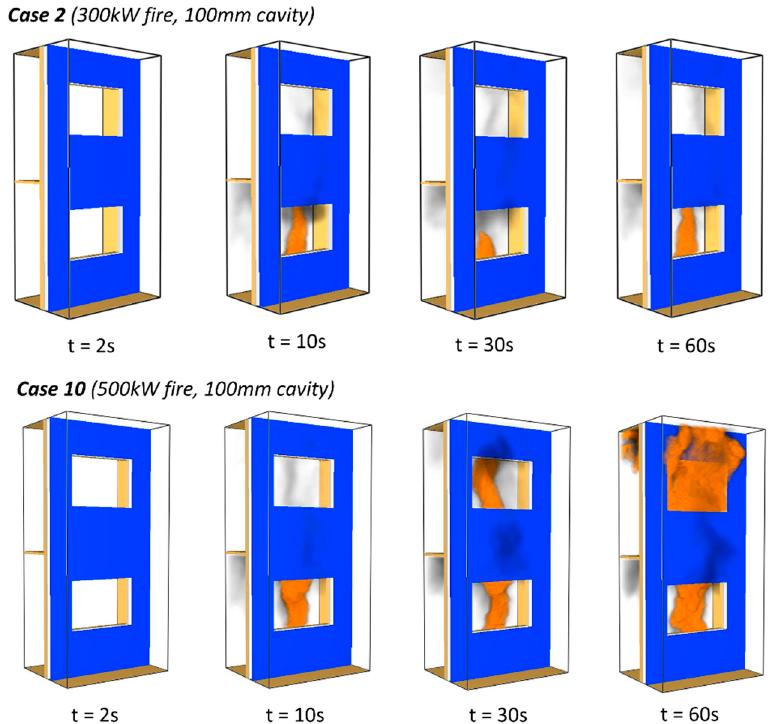
Figure 6. Heat release rate (HRR) and smoke rendering of Case 2 where there was no ignition and Case 10 where the fire spread over the entire external cladding.